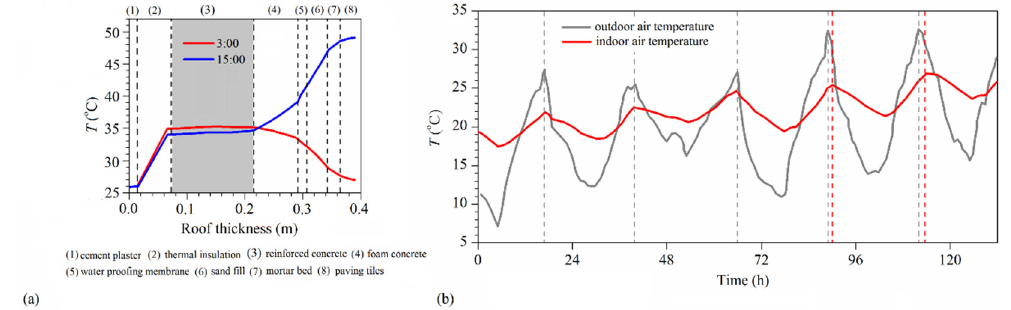
Figure 4. The results of previous papers; ( a ) temperature distribution across the roof thickness [20]; and ( b ) the variation of outdoor and indoor air temperature [21].